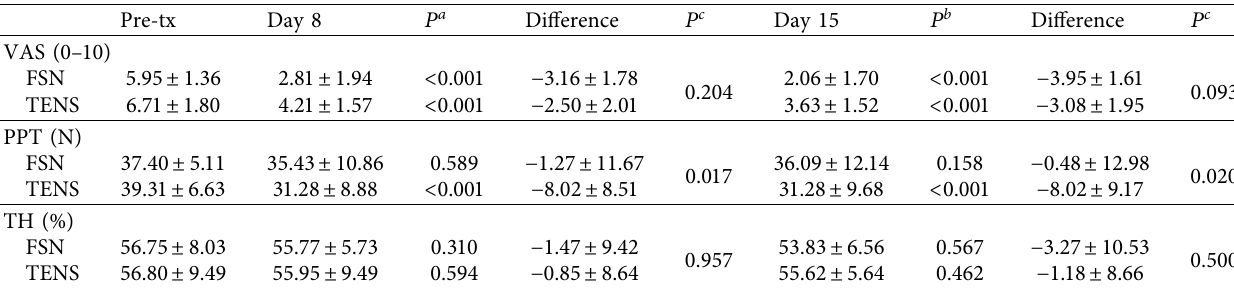
Figure 6: Comparison the immediate effects of the two groups. The pretreatment and posttreatment value of VAS (a), PPT (b), and TH (c) was measured in three treatment sessions in both groups. Asterisks ( ∗ ) showed the P < 0 . 05. VAS: visual analog scale, PPT: pressure pain threshold, and TH: tissue hardness. Table 3: Short-term and long-term effects of FSN and TENS groups on VAS, PPT, and